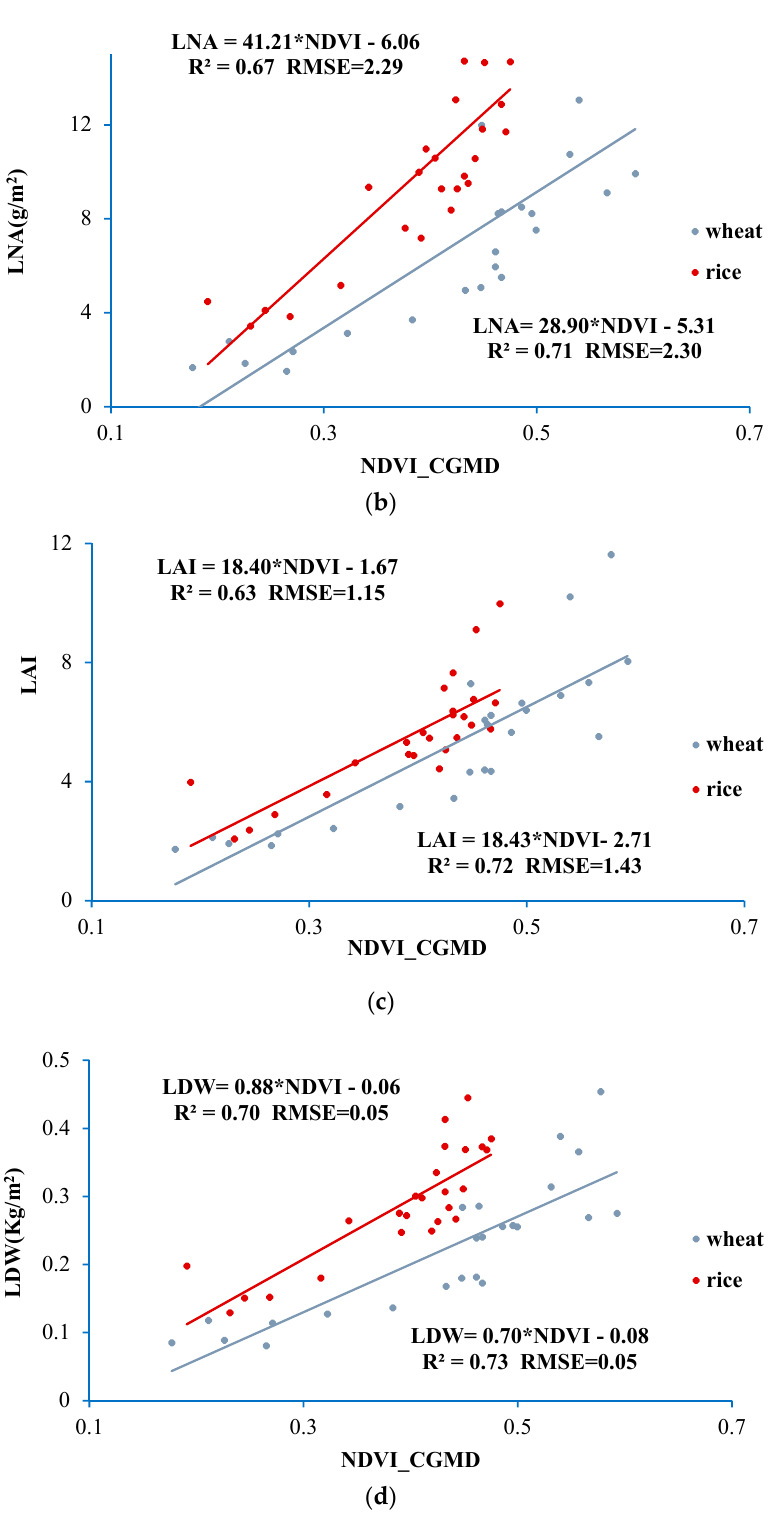
Figure 16. ( a ) Fitting curve of LNC-NDVI; ( b ) Fitting curve of LNA-NDVI; ( c ) Fitting curve of LAI-NDVI; ( d ) Fitting curve of LDA-NDVI; Spectral monitoring models for crop growth.